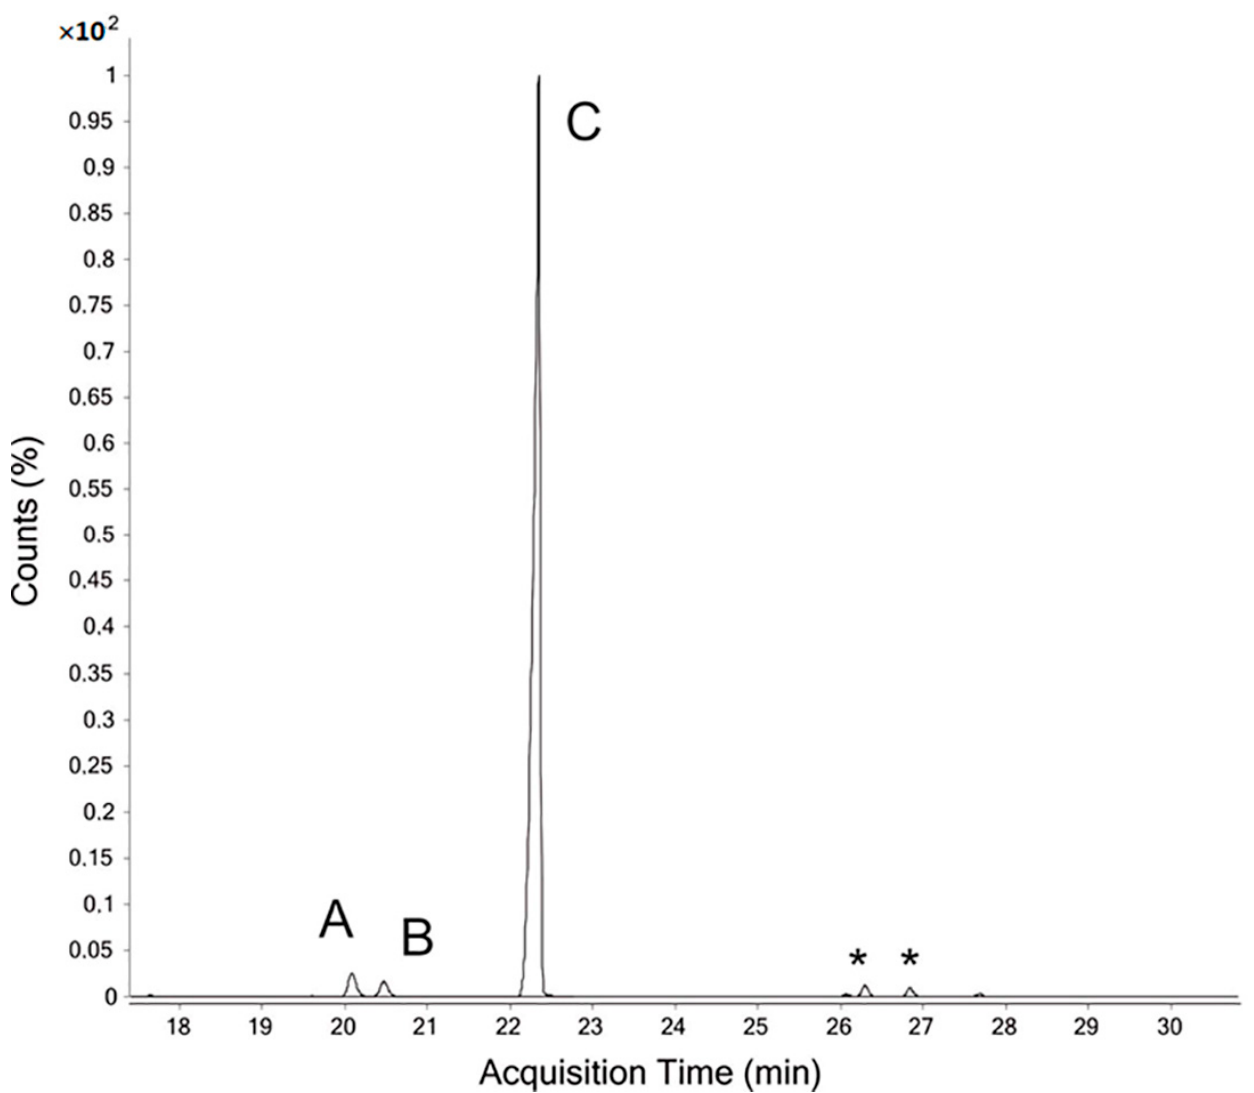
Figure 2. TIC chromatogram of PMAA derivatives obtained from sucrose (* disubstituted derivatives of glucose derived from starch, intrinsic contamination).